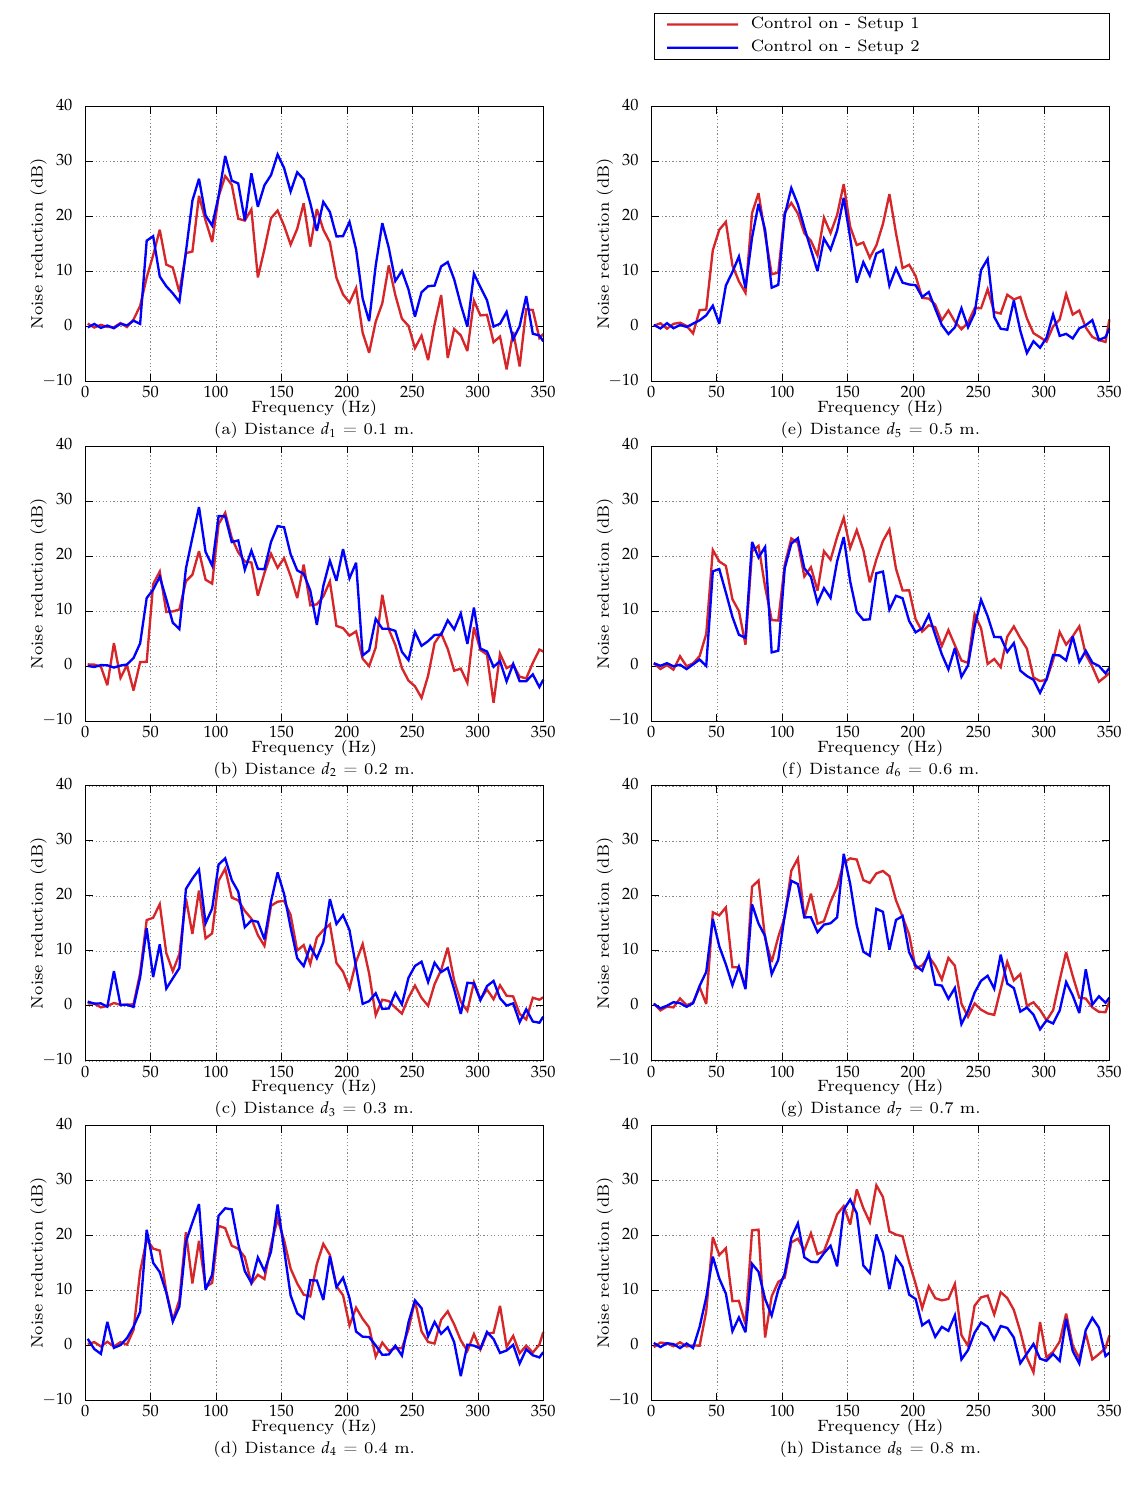
Figure 15. The averaged noise reduction for the noise sensed by the room microphones for each of the primary noise tones in the range 1 Hz to 350 Hz with a step of 5 Hz, for both Setup 1 and Setup 2. In Figure 14, the mean variance estimated based on the room microphones measurements is given for different distances d i , ranging from 0.1 m to 0.8 m. For each distance d i a plot is given, where black color represents primary noise without active control; red and blue colors represent